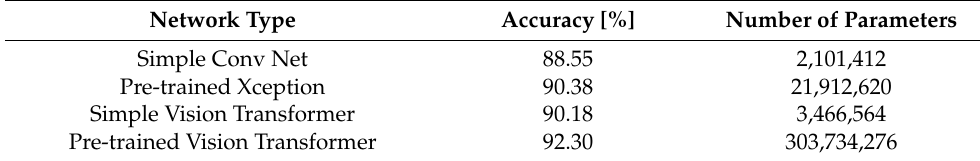
Table 1. Accuracies and parameters count for the best